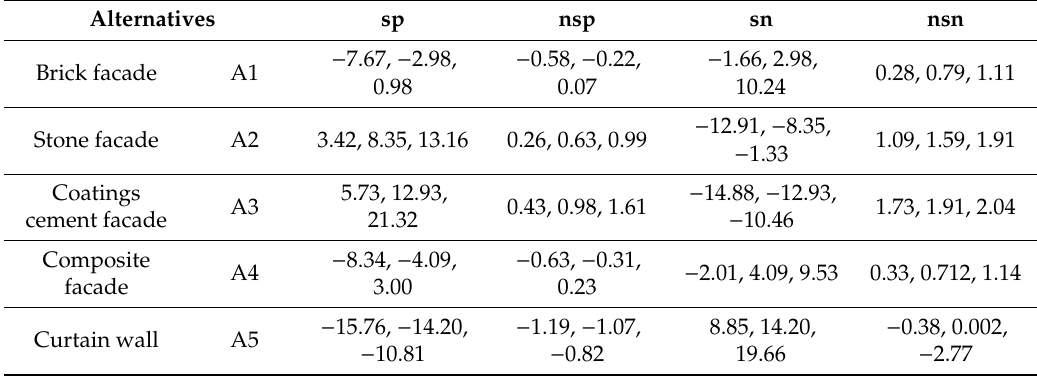
Table 10. Weighted positive and negative distances from average and related normalized values.